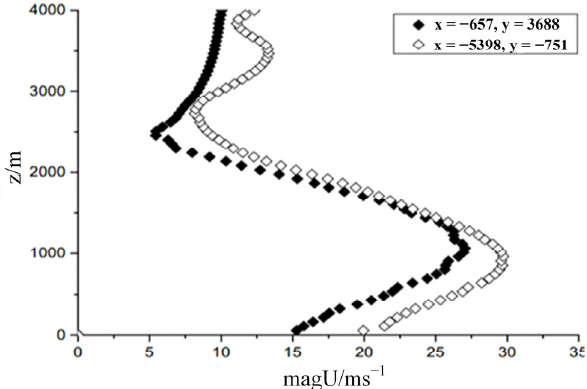
Figure 8. The resultant wind velocity profiles at different altitude over two positions (x = 657 m, y = 3688 m, and x = − 5398 m, y = 751 m) at t = 1000 s.